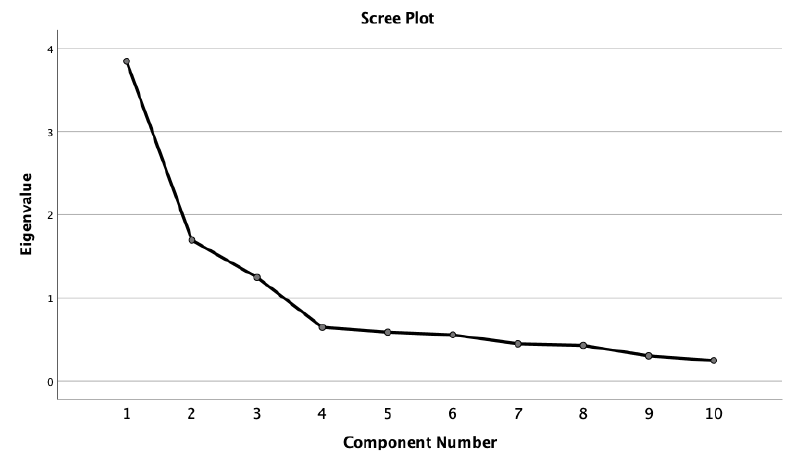
Figure 1. Scree plot representing the eigenvalues (10-item Fertility Adjustment Scale). In addition, a Varimax rotation with K1 presented a scale structure with Factor 1 (items 1, 3, 6, and 9), Factor 2 (items 4, 7, 8, and 10), and Factor 3 (items 2 and 5) (Table 5).